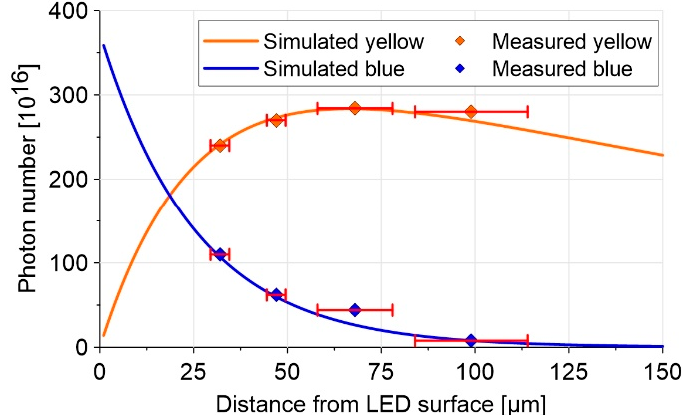
Figure 22. The photon numbers of blue and yellow light emitted at the top surface the phosphor layer, for different phosphor layer thicknesses.